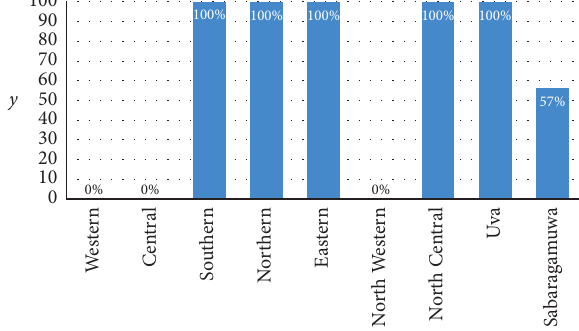
Figure 6: Optimal results for lockdown relaxation ( y : relaxation level as a percentage; number of ICU beds �